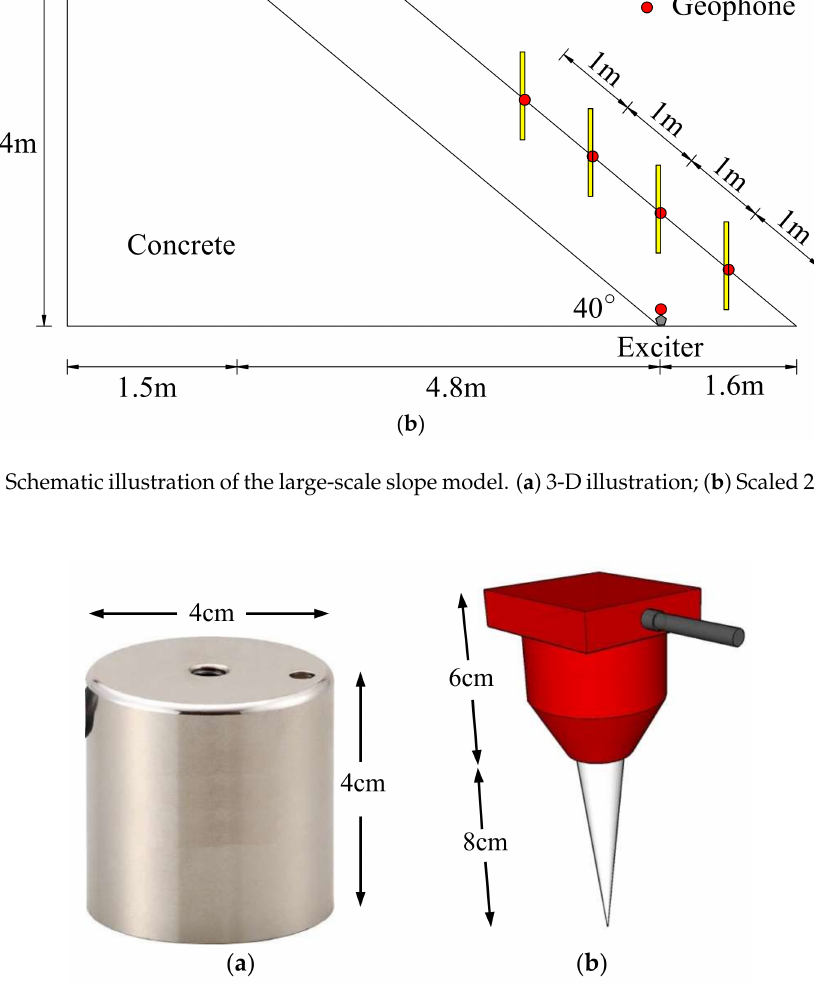
Figure 7. Electromagnetic holder and geophone used in large-scale model tests. ( a ) Electromagnetic holder. Similar to the solenoid, when an electric current is given, the electromagnetic holder produces magnetic field to attract an iron nut ( m = 92.6 g) upwards to hit itself. As a result, elastic wave is created. The nut falls down due to gravity upon removal of electric current; ( b )